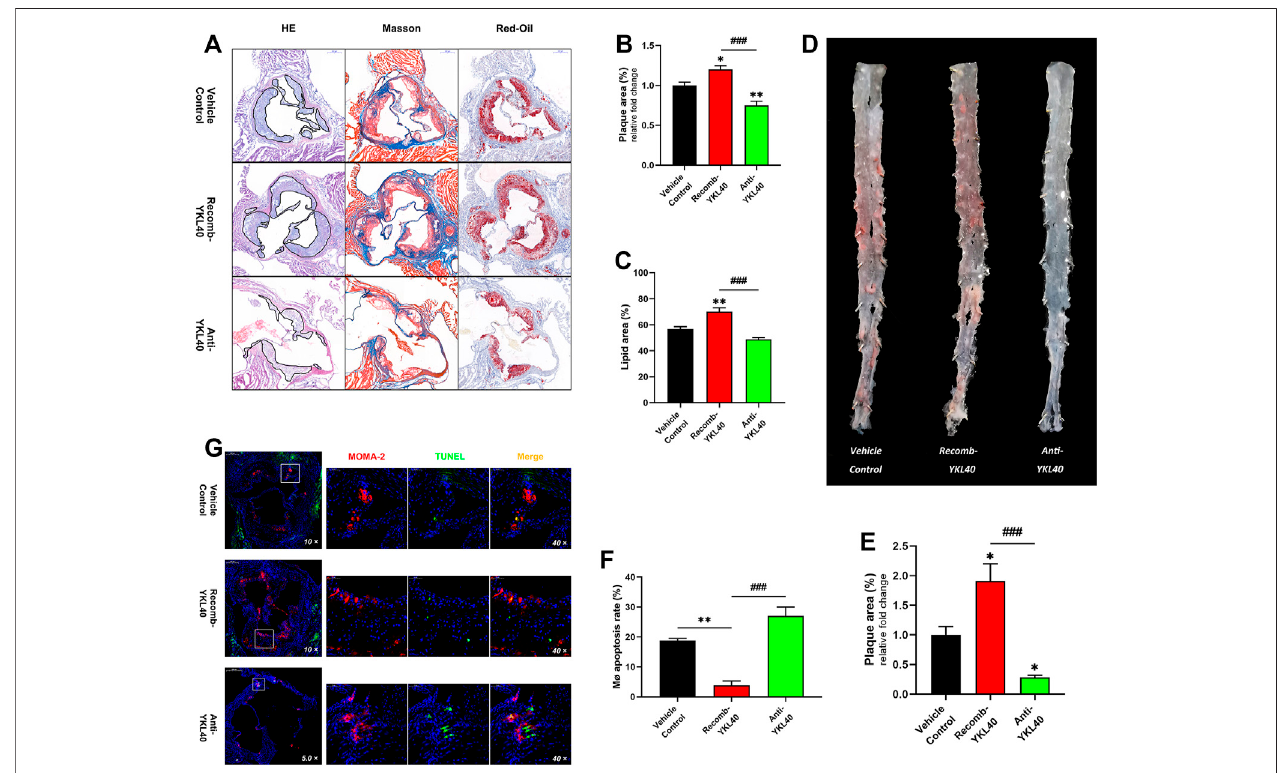
FIGURE 4 | (A – C) H&E, Masson, and oil-Red O staining of aortic roots (the area of plaque is outline in black). The plaque area of the aortic root was signi fi cantly largerintherecomb-YKL-40 groupthan thatinIgGgroup( p (cid:1) 0.0247)and intheanti-YKL-40 group ( p < 0.0001), andwhichwassigni fi cantlysmallerin theanti-YKL-40 groupthanintheIgGgroup( p (cid:1) 0.0067).Thelipidareawassigni fi cantlylargerintherecomb-YKL-40groupthanthatintheIgGgroup( p (cid:1) 0.0028)andintheanti-YKL-40 group( p (cid:1) 0.0001). (D,E) Oil-RedOstainingofthewholeaortas.Theplaqueareaofthewholeaortawassigni fi cantlylargerintherecomb-YKL-40groupthanthatin IgG group ( p (cid:1) 0.0126) and in the anti-YKL-40 group ( p (cid:1) 0.0001) and was signi fi cantly smaller in the anti-YKL-40 group than in the IgG group ( p (cid:1) 0.0464). (F,G) Immuno fl uorescence and TUNEL staining were performed on aortic root plaques (red indicates MOMA-2, green for TUNEL, and golden for MERGE). The